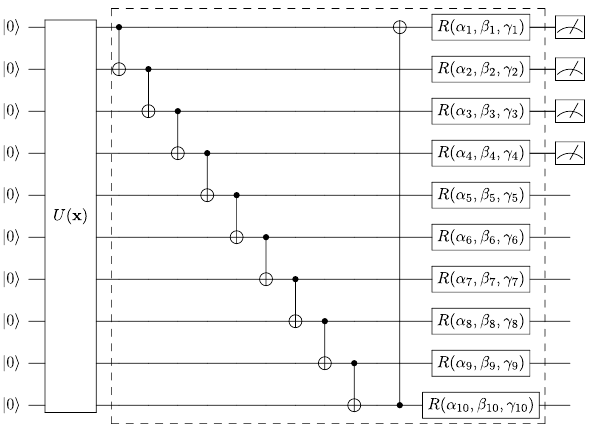
Figure 11. First quantum circuit block for MNIST classification. The first VQC block encodes the MNIST image. The 1024-dimensional vector is encoded via amplitude encoding into a log ( 1024 ) , i.e., 10-qubit state. U ( x ) denotes the quantum algorithm for amplitude encoding as explained in 77,78 . α i , β i , and γ i are the parameters to optimize. The dashed box denotes one block of a quantum circuit that is repeated eight times. Thus, there are 30 × 8 = 240 parameters to the circuit block. The dial to the far right represents that the circuit has four outputs. The expectation of σ z is measured on four qubits. The output becomes the input for the next circuit block.